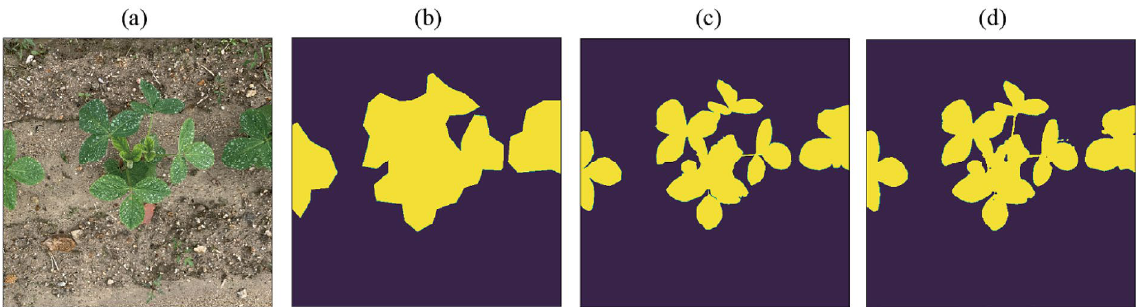
Figure 1. Bean-Field dataset sample. ( a ) input images, ( b ) MGRL, ( c ) CDTL, and ( d ) PLFL. Output was thresholded at